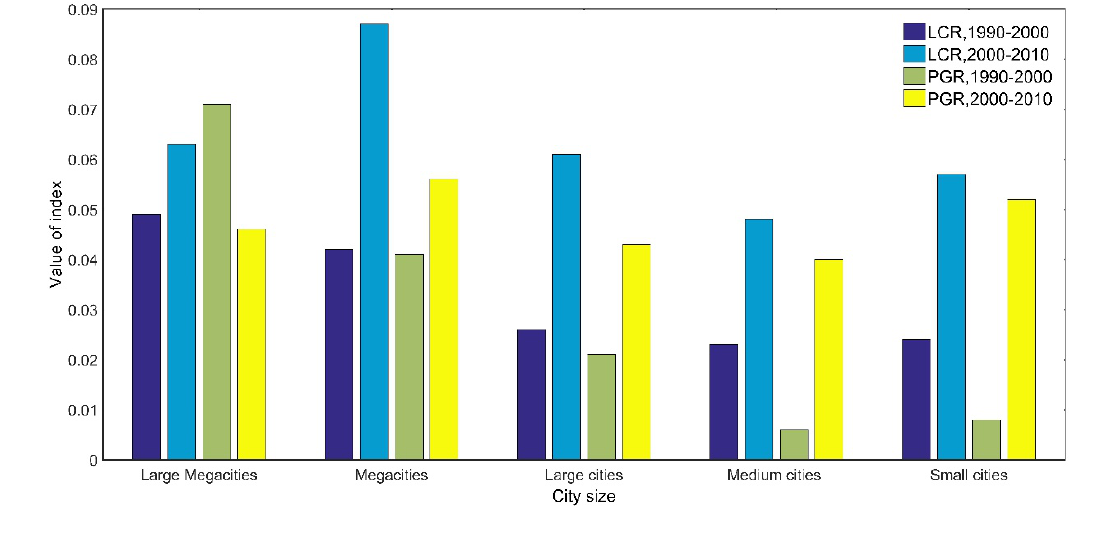
Figure 8. The average LCR and PGR in 1990–2010.